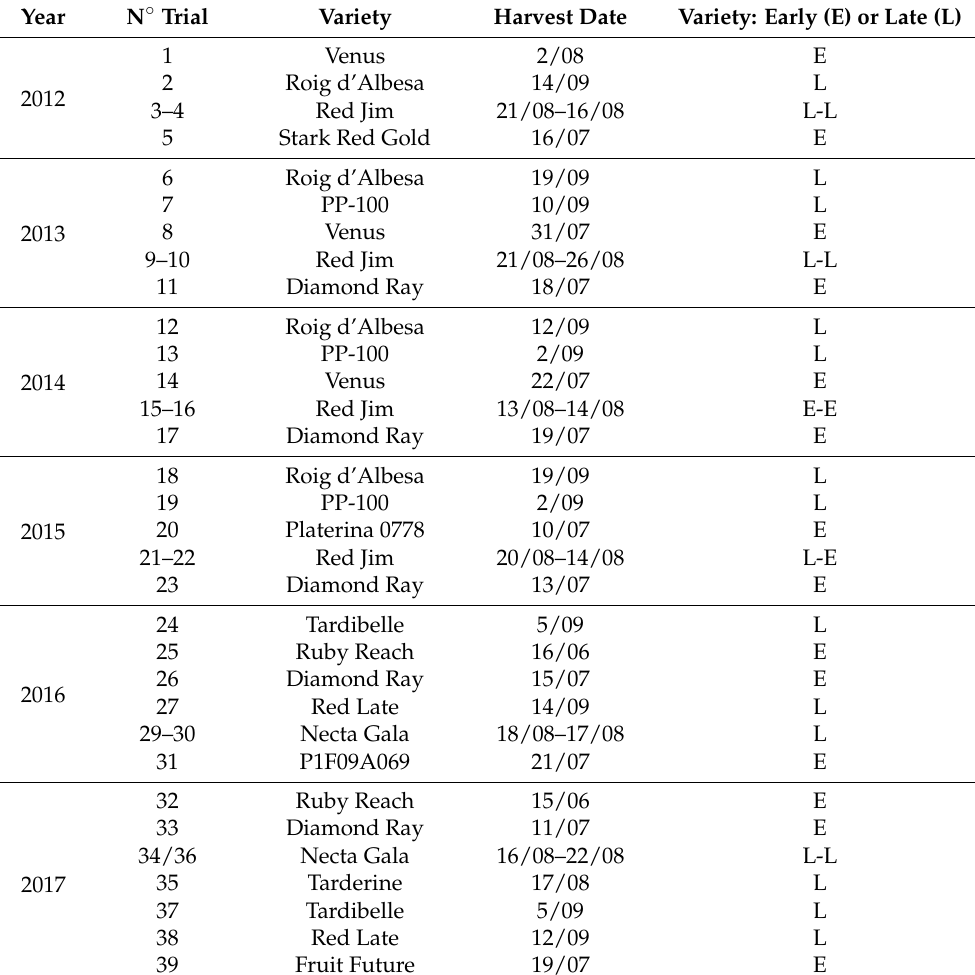
Table 1. Trials conducted for several seasons (2012–2017) for the validation of the Monilinia spp. warning system in stone fruit orchards. N ◦ Trial Variety Harvest Date Variety: Early (E) or Late